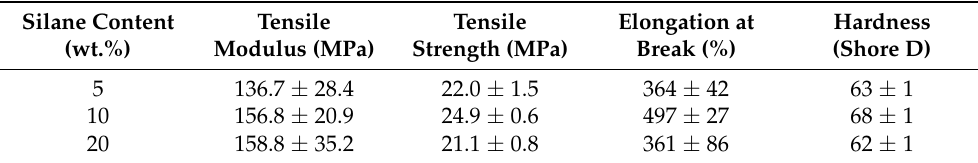
Table 10. Tensile properties of treated Sm 2 O 3 /UHMWPE composites with varying silane contents of 5, 10, and 20